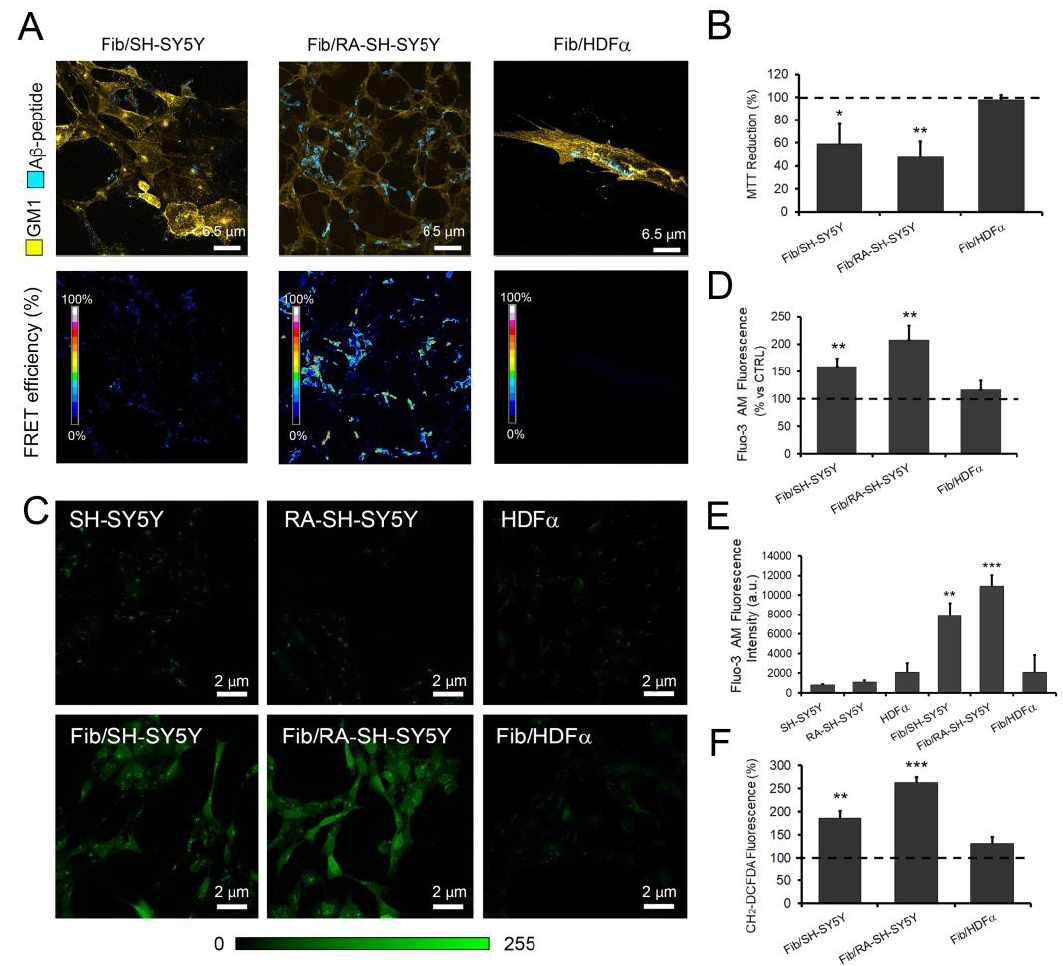
Figure 1. Different cell line susceptibilities to A β -42 amyloid toxicity. ( A ) Top panels: Confocal Z-projections of SH-SY5Y, RA-SH-SY5Y and HDF α cells stained to reveal GM1 (yellow) on cell membranes. Cells were treated for 24 h with 2.5 µ M (monomer concentration) A β -42 Fib solution. Bottom panels: sensitized FRET analysis of GM1 fluorescence staining and fibril immunofluorescence; a 16-color scale was used to represent FRET efficiency. ( B ) Cell viability assessed by the MTT reduction assay on cells treated for 24 h with 2.5 µ M A β -42 Fib solution: results were expressed as percentage decreases with respect to own controls. Error bars indicate the SD of five independent experiments carried out in triplicate. * p < 0.05; ** p < 0.01 vs. untreated (control) cells. ( C ) Representative confocal scanning microscopy images of intracellular calcium levels detected in HDF α , SH-SY5Y and RA-SH-SY5Y cells treated for 1 h with 2.5 µ M A β -42 Fib solution (Fib/HDF α , Fib/SH-SY5Y and Fib/RA-SH-SY5Y) and in control fibroblasts and neuroblastoma cells (HDF α , SH-SY5Y and RA-SH-SY5Y). ( D ) Semiquantitative evaluation of intracellular calcium levels detected by confocal analysis. Variable numbers of cells (60–90) in five independent experiments were analyzed for each condition. ( E ) Semi-quantitative analysis of intracellular free Ca 2+ -derived fluorescence in 96-well plates. Error bars indicate the SD of five independent experiments. ** p < 0.01; *** p < 0.001 vs. control cells. ( F ) Intracellular ROS production in HDF α , SH-SY5Y and RA-SH-SY5Y cells treated for 24 h with 2.5 µ M A β -42 Fib solution (Fib/HDF α , Fib/SH-SY5Y and Fib/RA-SH-SY5Y) and in fibroblasts and neuroblastoma cells not treated with amyloid (HDF α , SH-SY5Y and RA-SH-SY5Y). Error bars indicate the SD of five independent experiments carried out in triplicate. ** p < 0.01; *** p < 0.001 vs. control